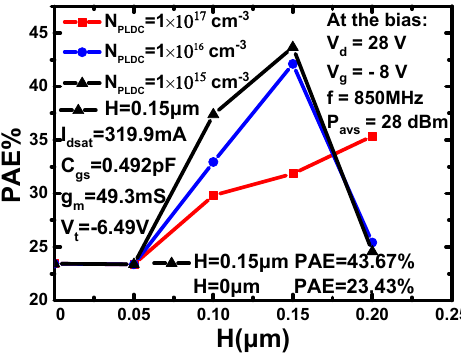
Figure 3. The effects of N PLDC and H on the PAE.